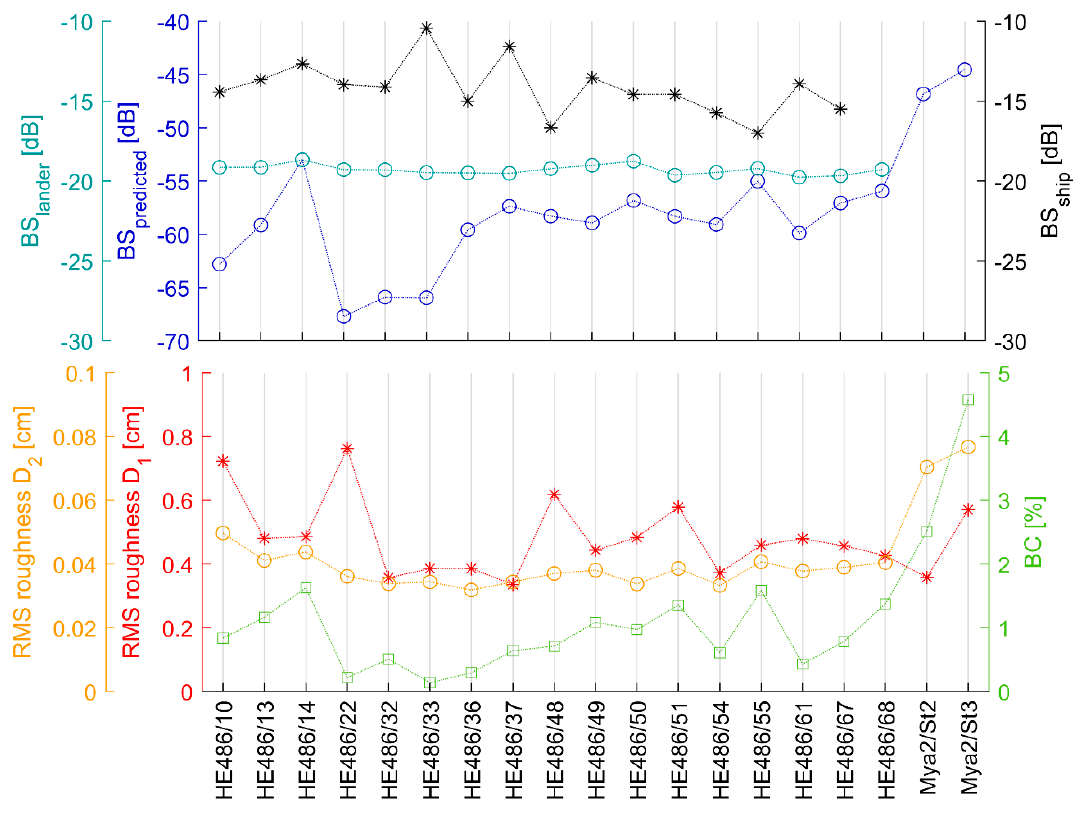
Figure 4. Predicted backscatter strength using the small-roughness perturbation approximation (blue), the measured backscatter strength (BS) from the lander (cyan), the measured backscatter strength from the ship-based system (black), root-mean-square roughness (RMS roughness) for the D 1 interval (red), RMS roughness for the D 2 interval (yellow), and benthic coverage (BC) at the seafloor for the lander stations (green). The last two station digits correspond to the position of the lander stations displayed in Figure 1.